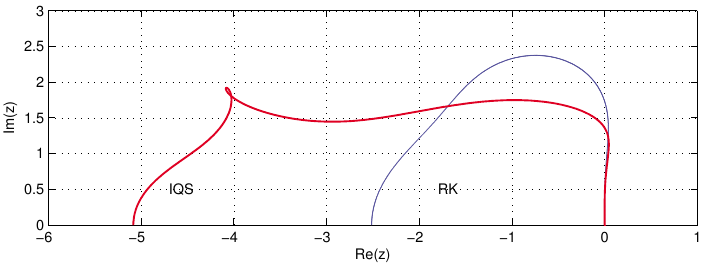
Figure 7. Stability regions of RK method of order p = 3 and GLMs with p = q = s = 3, r = 4 with